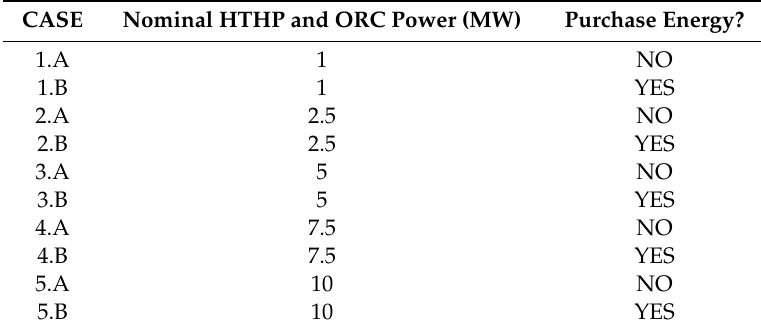
Table 1. Parametric studies for the proposed CHEST system integrated in the wind power plant under